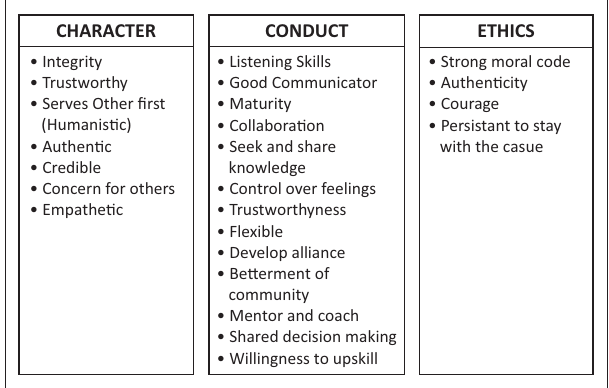
FIGURE 2: Servant-as-leader: Retirement fund trustee